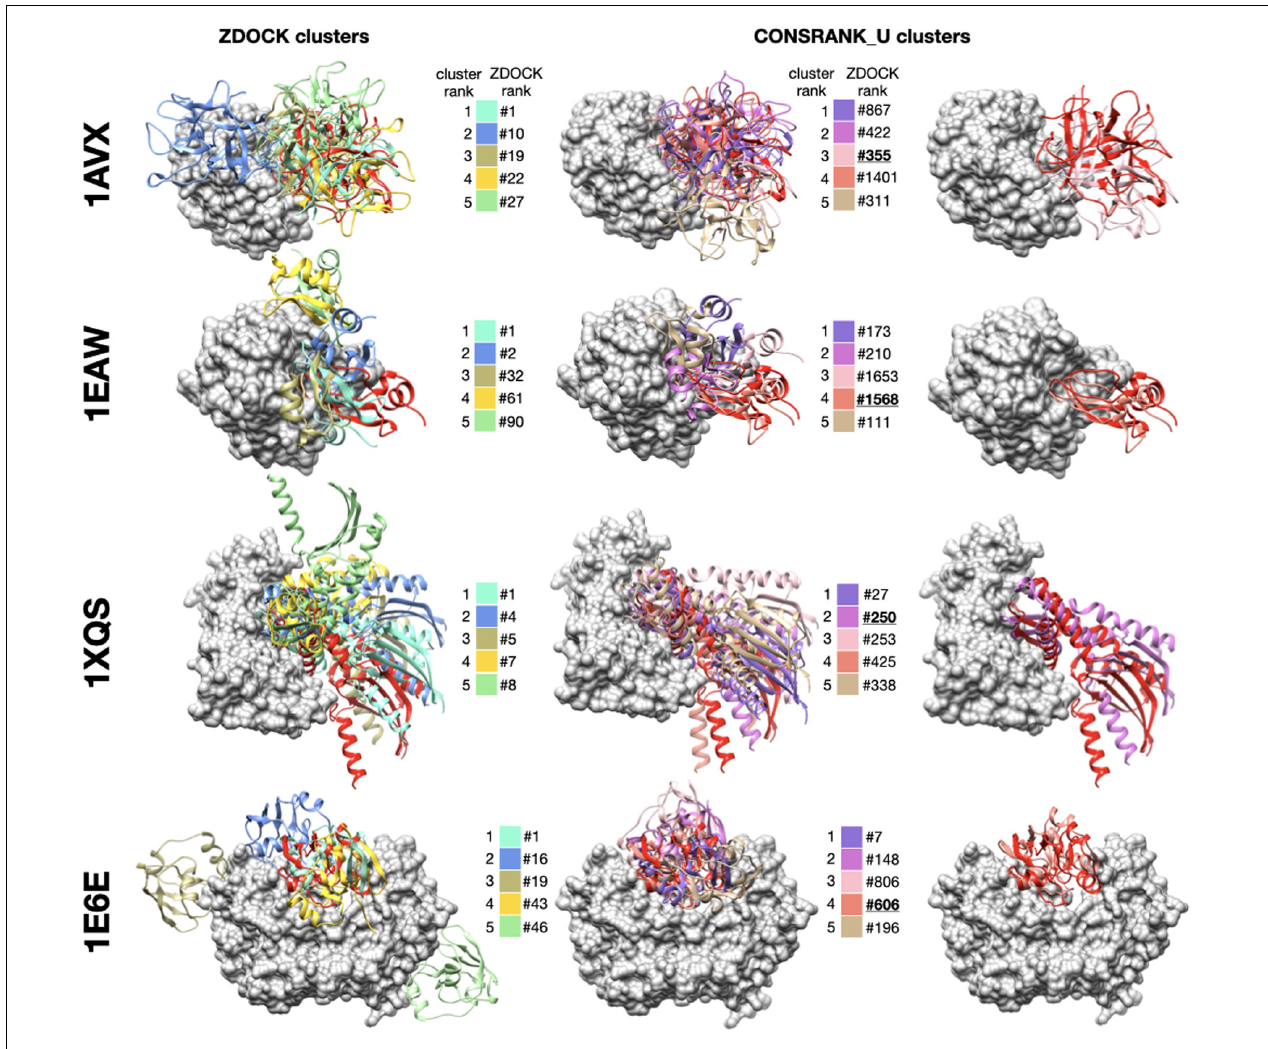
FIGURE 4 | Examples of successful combination of ZDOCK clusters and consensus-based clusters. For each protein–protein complex, the receptor protein is represented as a gray surface and the ligand as a red ribbon. Left column: representative poses of the first five clusters generated with ZDOCK native scoring function, middle column: representative poses of the first five clusters generated with the CONSRANK_U rescoring function, right column: superimposition between near-native docking hit and native structure. For each representative pose, initial ZDOCK rank is indicated next to the color legend. Near-native poses are underlined. 1AVX (Song and Suh, 1998): complex between the porcine trypsin (gray) and soybean inhibitor (red), 1EAW (Friedrich et al., 2002): complex between the catalytic domain of serine proteinase MT-SP1 (gray) and bovine inhibitor (red), 1XQS (Shomura et al., 2005): complex between the human Hsp70 binding protein 1 (gray) and Hsp70 (red), 1E6E (Müller et al., 2001): complex between NADPH:adrenodoxin oxidoreductase (gray) and adrenoxin